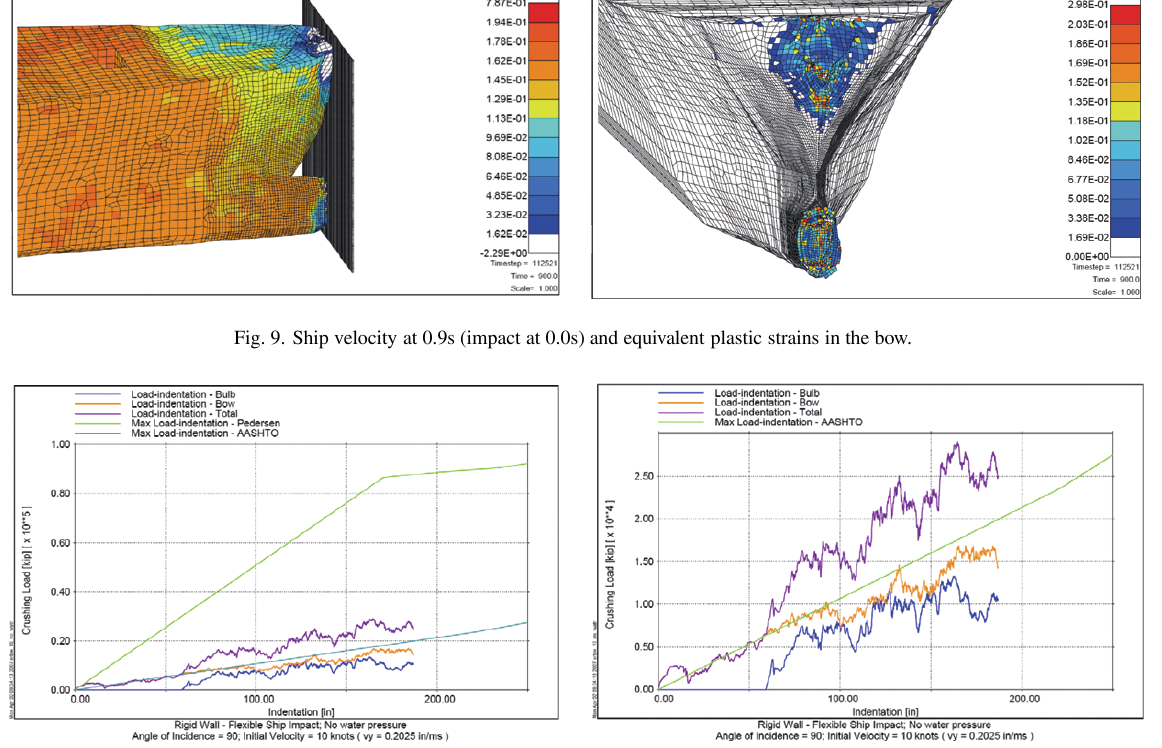
Fig. 10. Impact Load-Indentation history plots – comparison between numerical and analytical results (bottom plot – reduced crushing load scale). analysis are compared with those obtained using the analytical methods. The contour plot of ship velocity at 0.9s and equivalent plastic strains are shown in Fig.